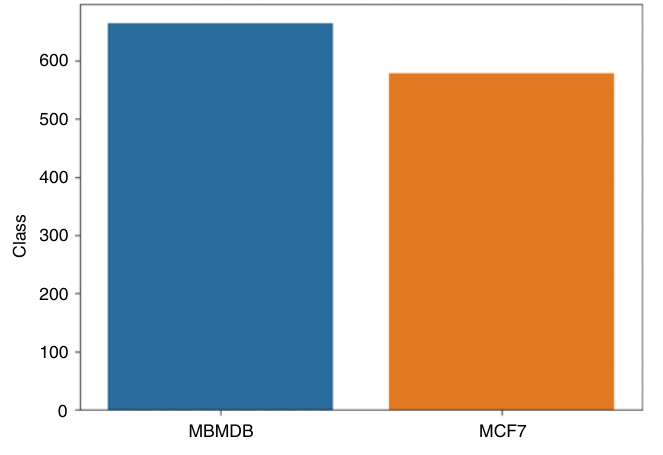
Figure 2. The complete